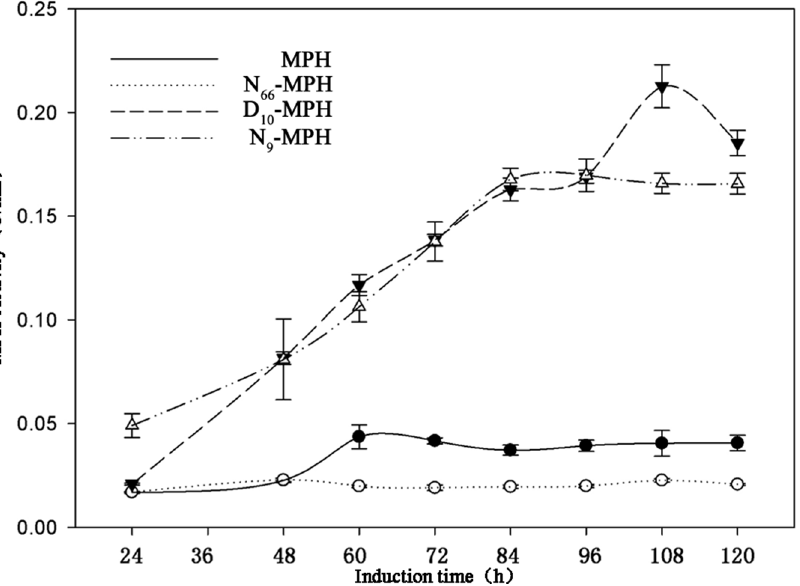
Figure 3. Enzyme activity in culture supernatants. MPH-24 # (solid circle), N 66 -MPH-5 # (hollow circle), D 10 -MPH-56 # (solid triangle), and N 9 - MPH-70 # (hollow triangle) were induced by methanol for various time periods (as indicated on the x-axis). The MPH activities in the supernatants were determined using standard enzyme assays and are shown on the y-axis. Enzyme activity is expressed as the mean of three samples, and error bars indicate standard deviation (SD).